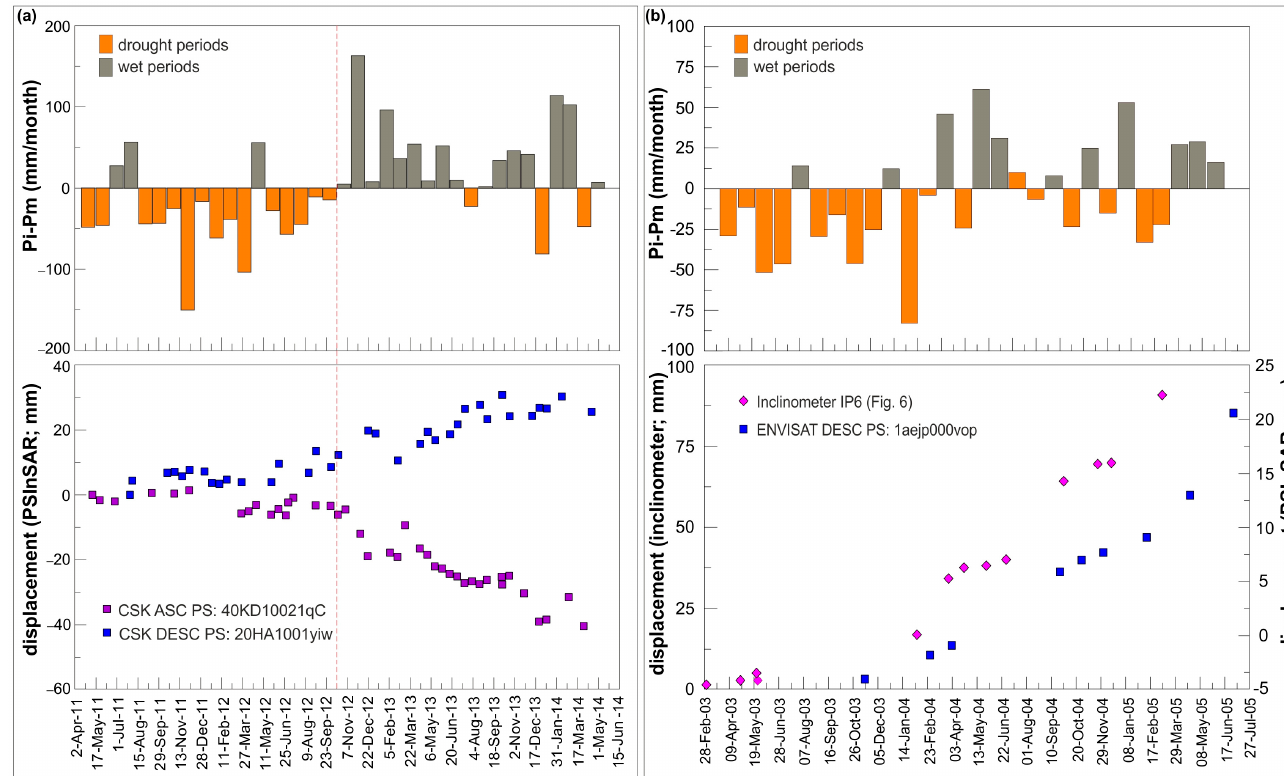
Figure 9. ( a ) Cumulative displacement of two CSK PS points (Figures 5c and 6b) vs. rainfall anomaly from mean monthly rainfall (Montemartano rain gauge data); ( b ) Cumulative displacement of the ENVISAT PS point in Figure 6c and displacement registered at inclinometer IP6 vs. rainfall anomaly from mean monthly rainfall (San Silvestro rain gauge data). Pi = rainfall of month i; Pm = mean rainfall of month i.